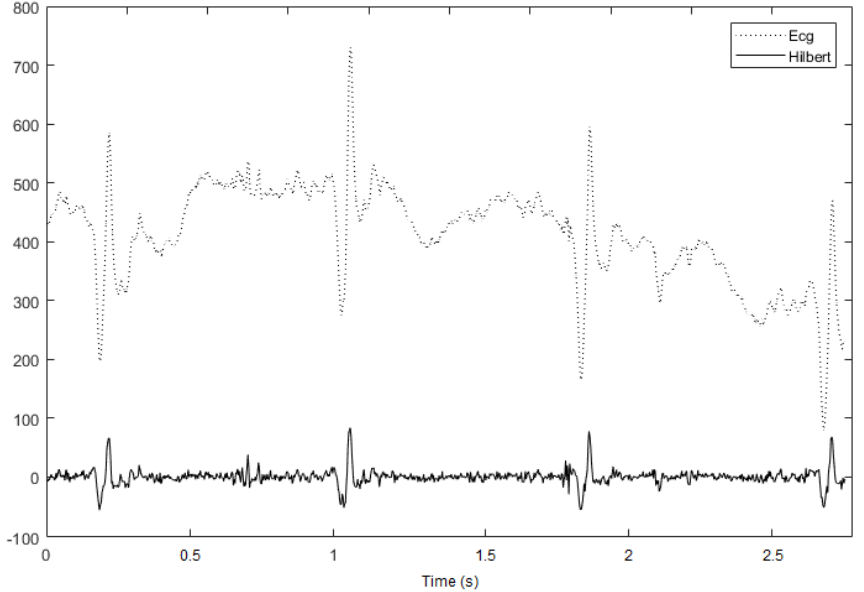
Figure 3. Overview of the signal at the output of stage 2 compared to the original signal.